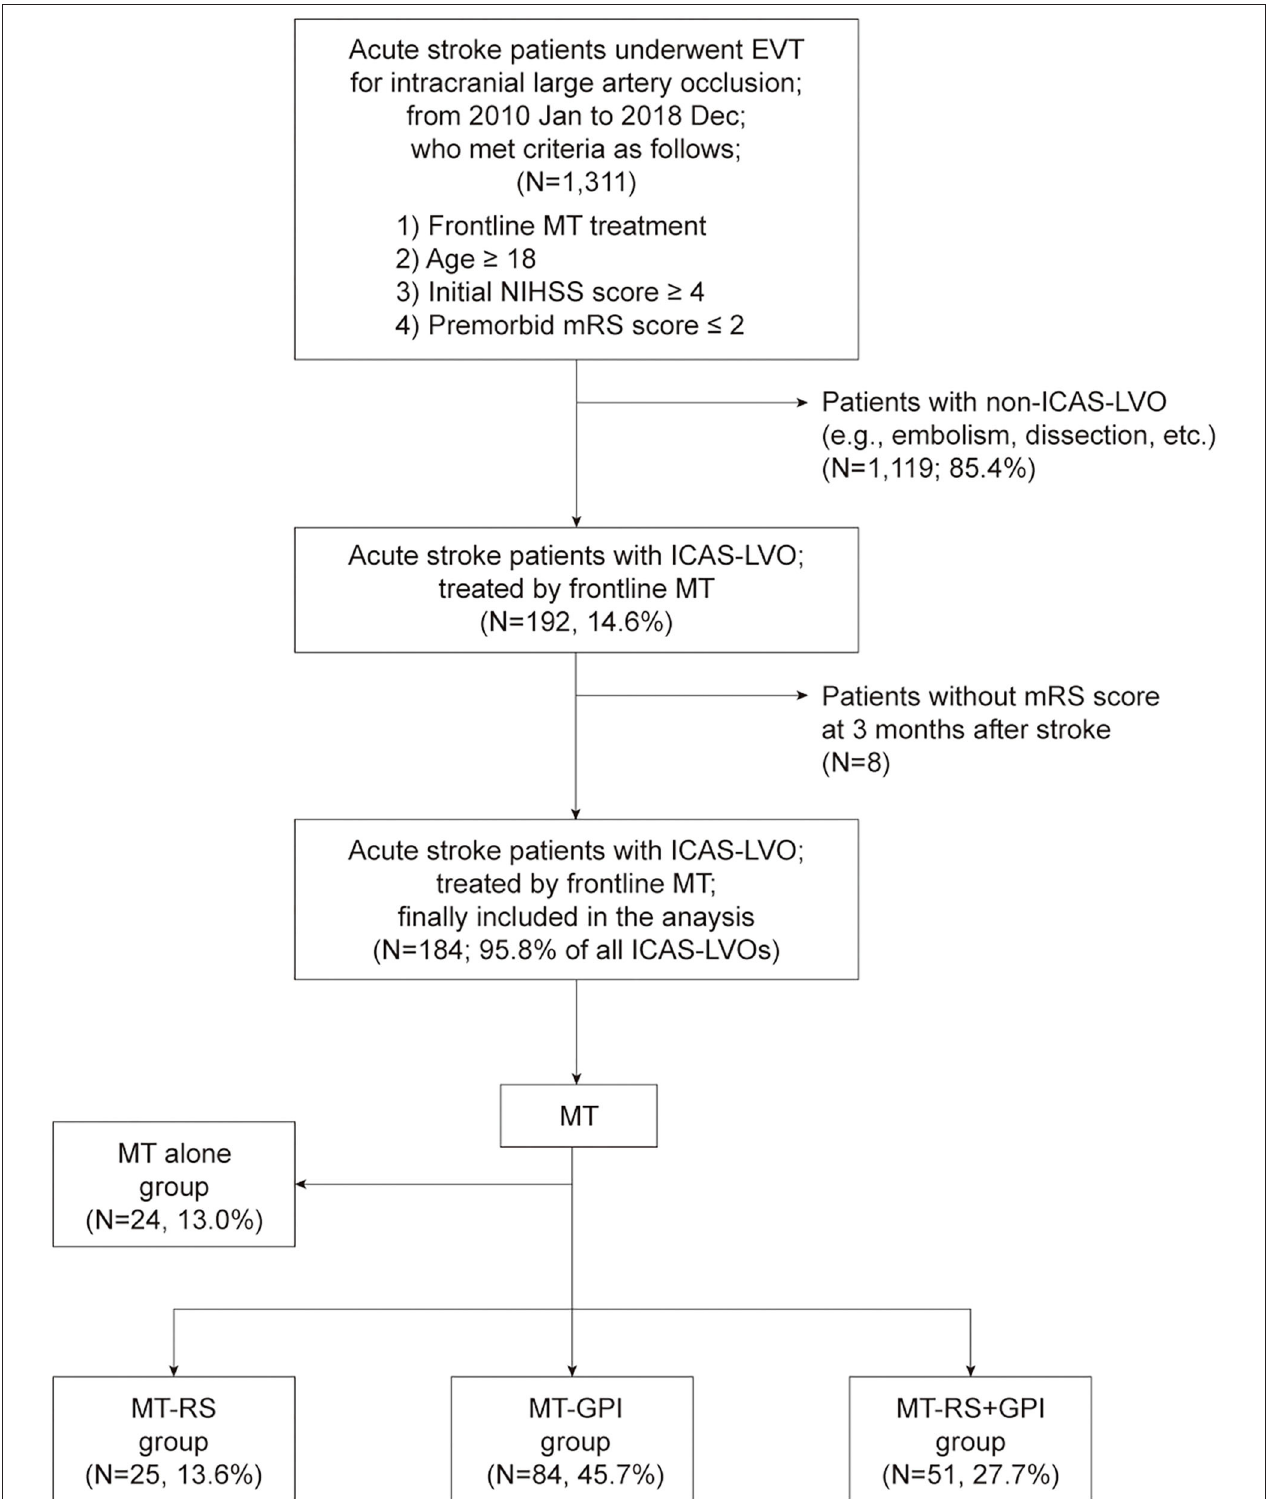
FIGURE 1 | Patient selection flow and grouping. EVT, endovascular treatment; MT, mechanical thrombectomy; NIHSS, National Institutes of Health Stroke Scale; mRS, modified Rankin Scale; ICAS-LVO, intracranial atherosclerosis-related large-vessel occlusion; MT-RS, rescue stenting after mechanical thrombectomy failure; MT-GPI, glycoprotein IIb/IIIa infusion after mechanical thrombectomy failure; MT-RS + GPI, rescue stenting with glycoprotein IIb/IIIa infusion after mechanical thrombectomy failure.